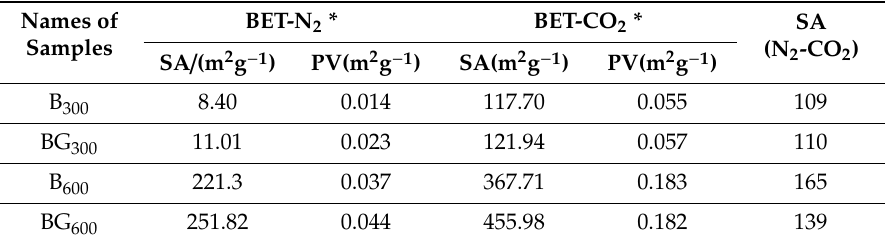
Table 2. Specific surface area and pore volume based on XPS results.